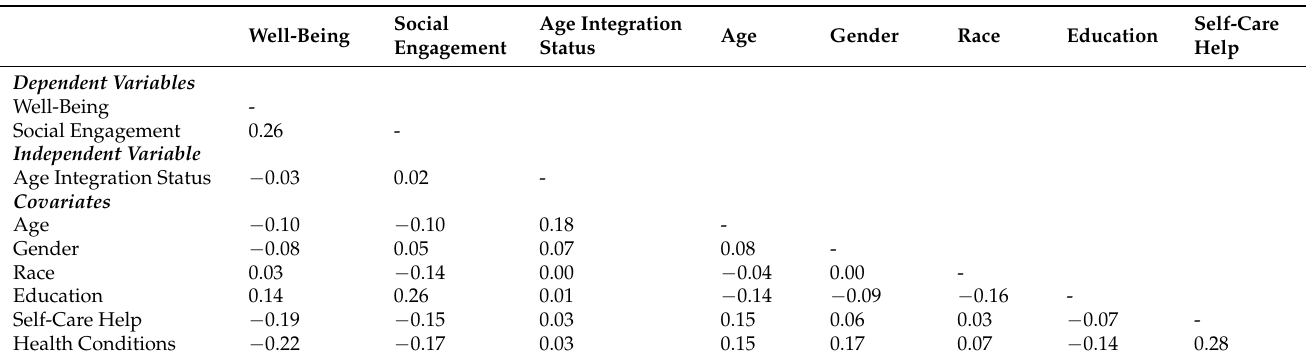
Table A2. Correlation Matrix of Dependent Variables, Independent Variable, and Covariates.